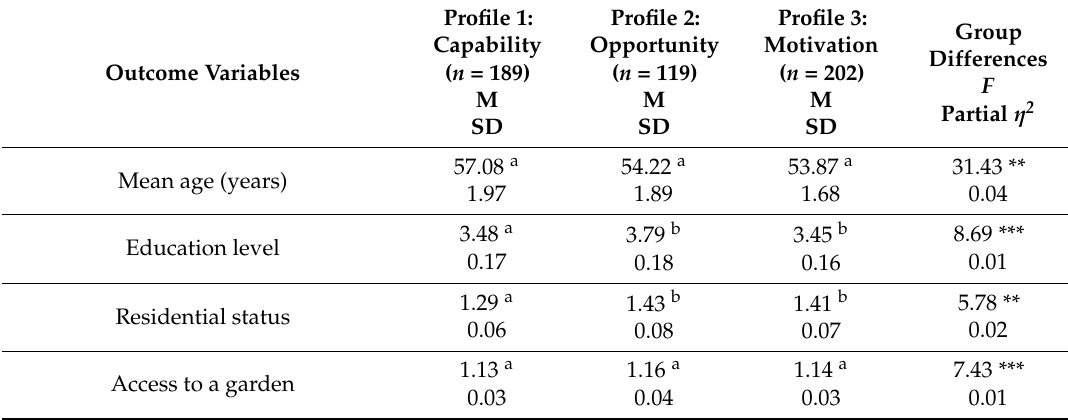
Table 2. Key demographic and outcome variables: mean (M), standard deviation (SD), and group